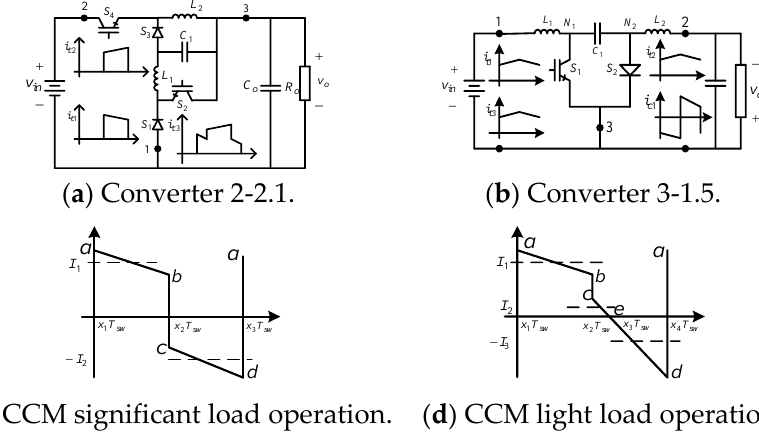
Figure 11. Some of group 2 converters and their capacitor current waveforms .